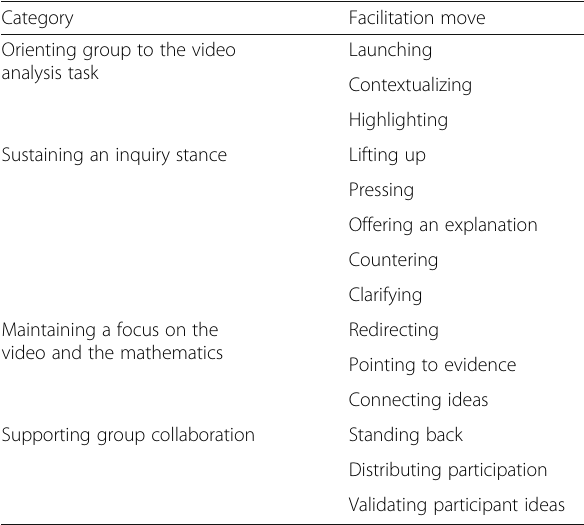
Table 1 Van Es et al. ’ s (2014) framework for facilitating of video-